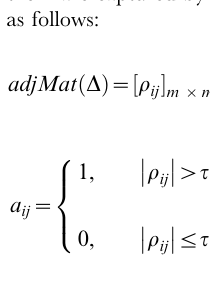
Table 9. Sample correlation scores of highly correlated genes (Focal adhesion and Regulation of actin cytoskeleton pathways).